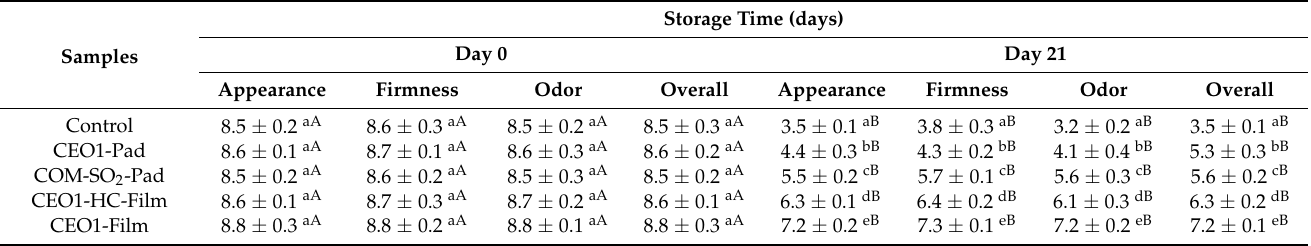
Table 3. Acceptance score of table grapes without and with antifungal packaging supplemented with 1% CEO at day 0 and day 21 of storage at 13 ◦ C and RH